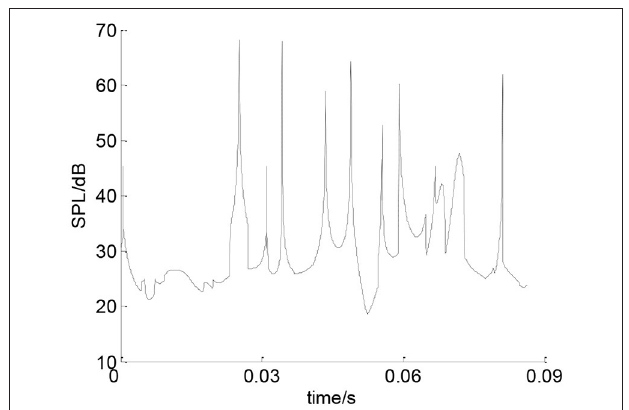
FIGURE 14 | The total SPL of the deep groove ball bearing at point A.